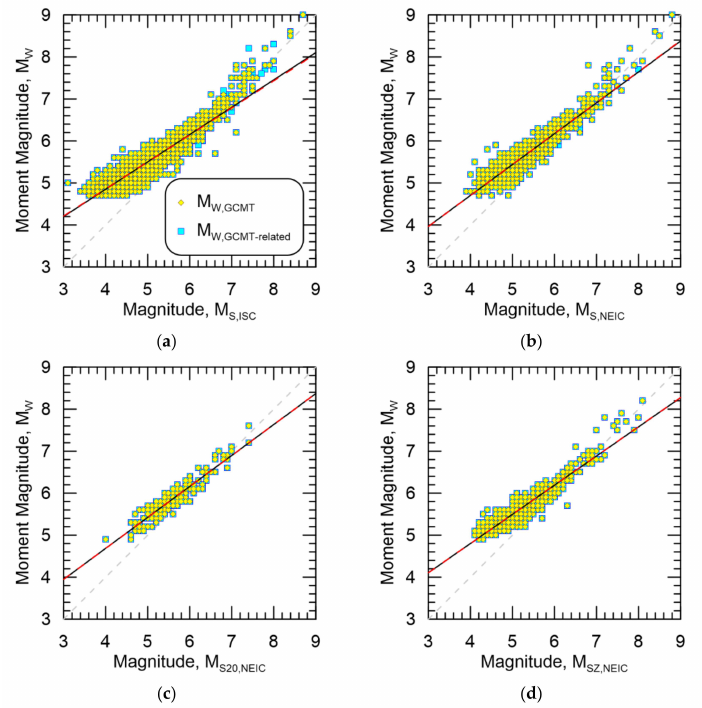
Figure 4. Resultant magnitude homogenization regressions for M W,GCMT-related against ( a ) M S,ISC , Appl. Sci. 2022 , 12 , x FOR PEER REVIEW 10 of 22 ( b ) M S,NEIC , ( c ) M S20,NEIC , ( d ) M SZ,NEIC . Data from M W,GCMT are also shown. Black line is the regression against M W,GCMT-related while the dashed red line is the regression against M W,GCMT .